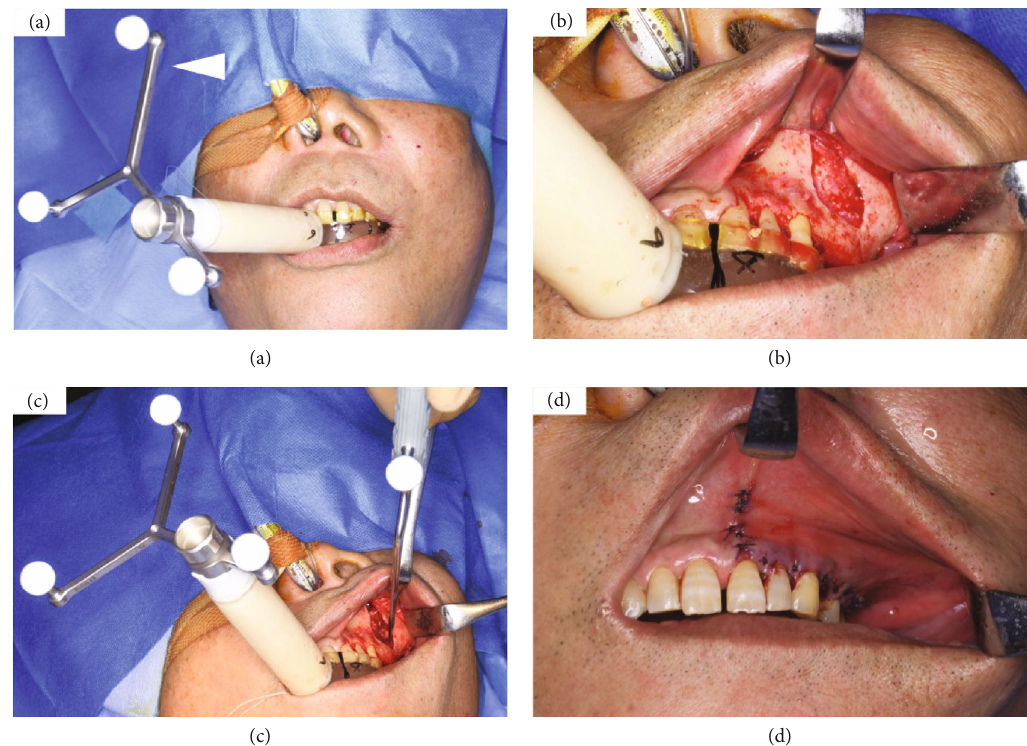
Figure 8: Intraoperative photographs. (a) The custom-made splint, which was integrated with the reference frame (white arrowhead), is set on the maxillary dentition. (b) The surgical fi eld can be viewed clearly. (c) The positions of the osteolytic lesion are accurately identi fi ed in the surgical fi eld using the pointer. (d) Placement of simple sutures at the vertical incision and horizontal mattress suture at the gingival